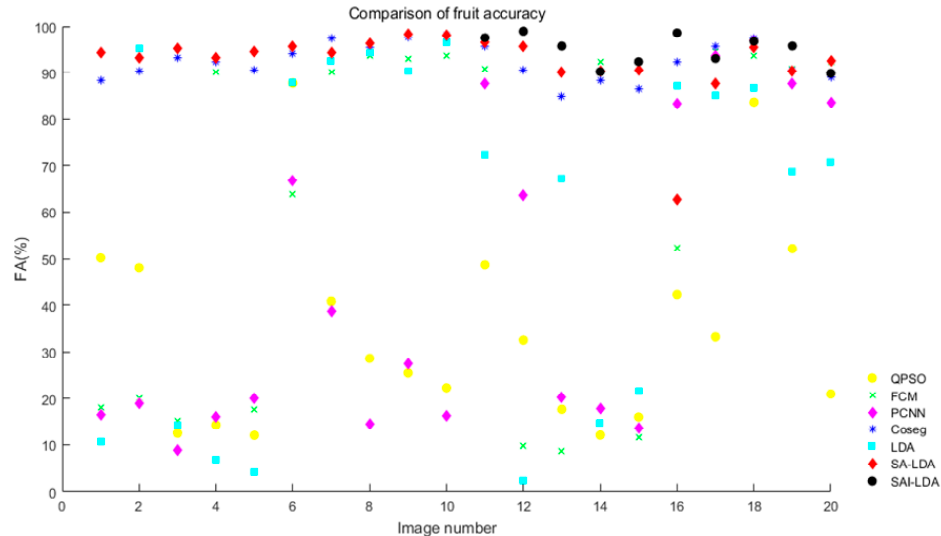
Figure 21. The result of fruit accuracy with different algorithms.